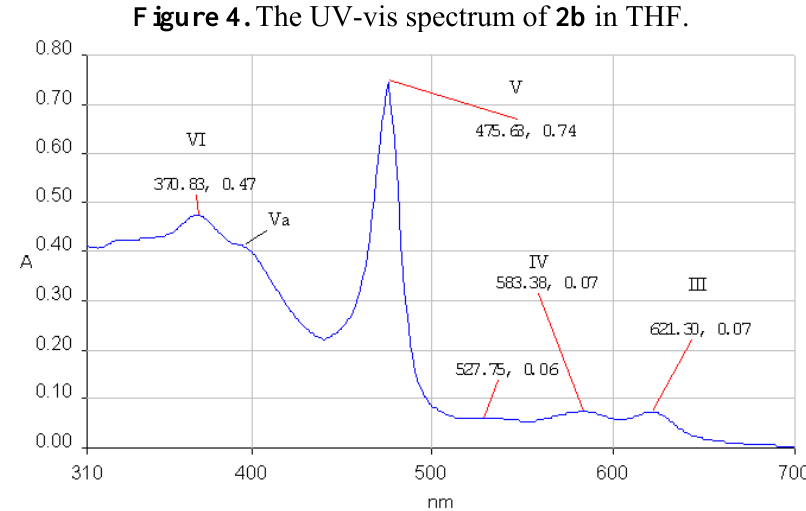
Figure 4. The UV-vis spectrum of 2b in THF.